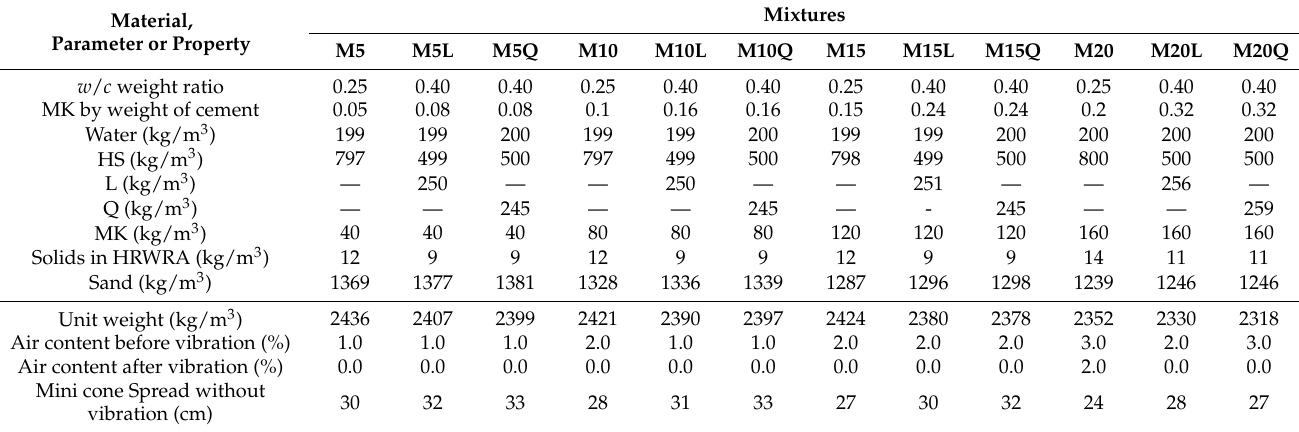
Table 3. Proportions and fresh stage properties for the mixtures evaluated in this